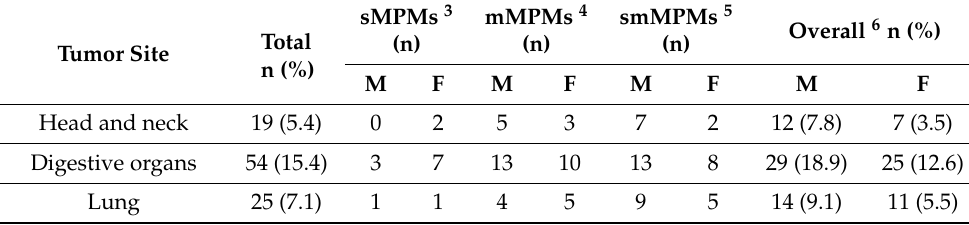
Table 5. Tumor site distribution based on